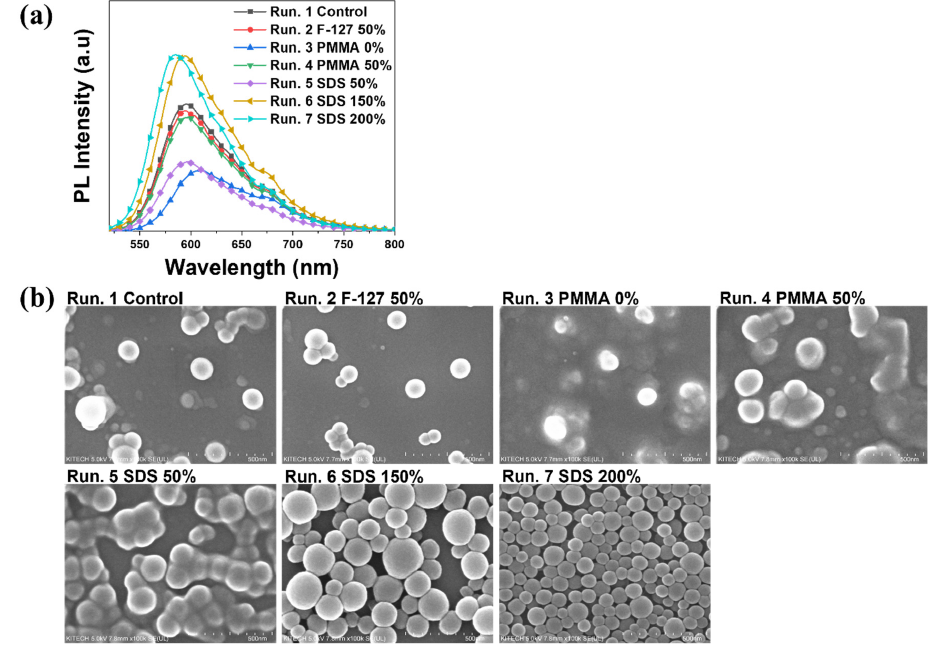
Figure 3. ( a ) PL spectra and ( b ) SEM images of DPP ‐ based AIE NPs prepared by Table 1 recipes. (Concentration of 0.5 mg/mL DP ‐ O).